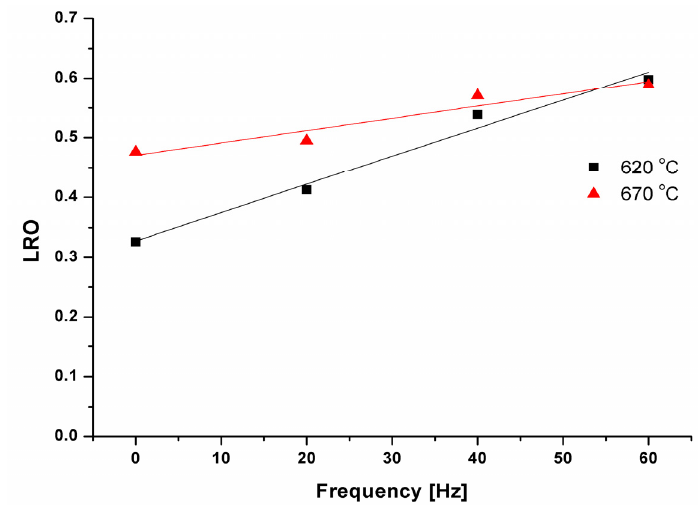
Figure 3. An influence of the pre-sintering parameters on the long-range order (LRO) of FeAl phase.